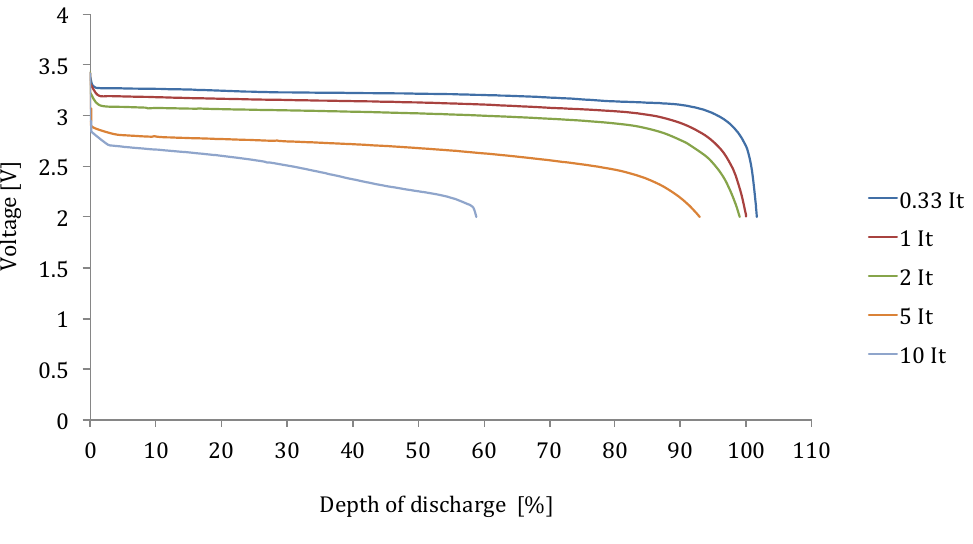
Figure 13. Discharge behaviour of battery brand O-LFP (high